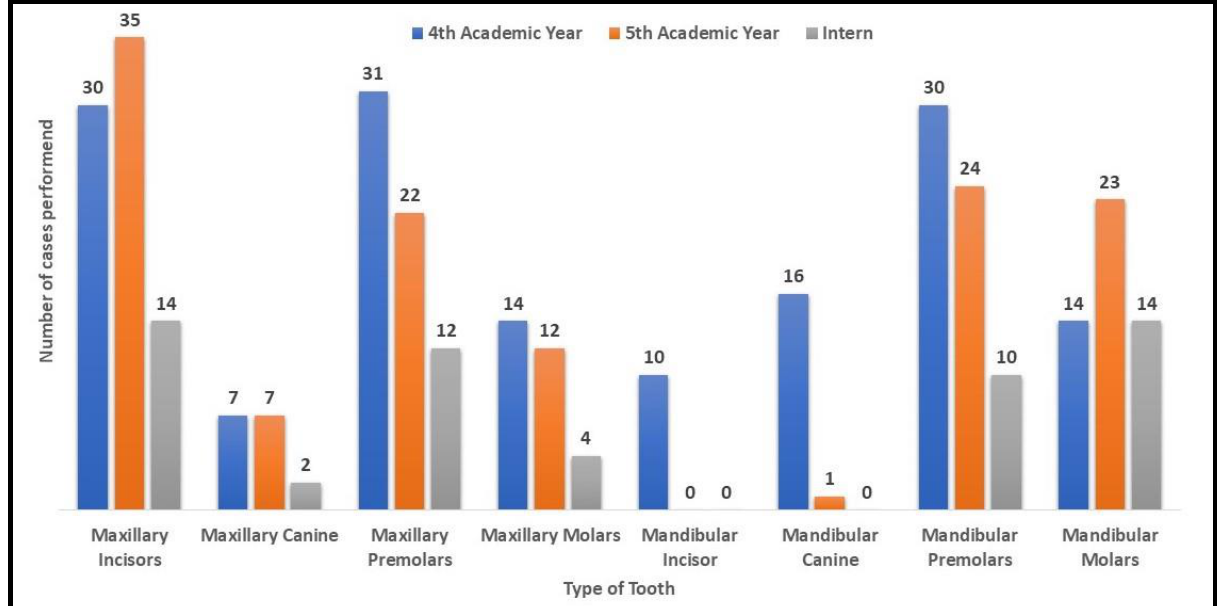
Figure 1. Number of endodontic treatments performed (tooth type-wise) by students of different academic levels.